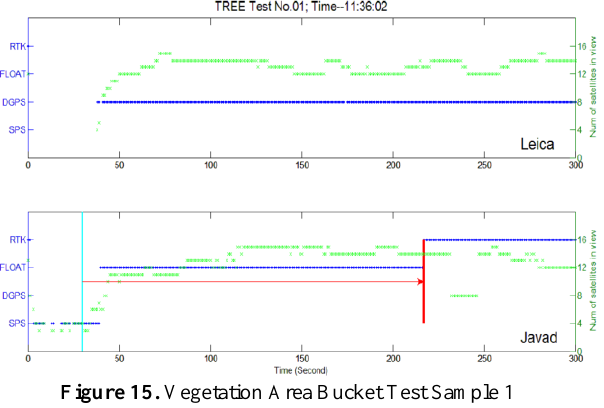
Figure 12. Open Area Bucket Test Sample 1